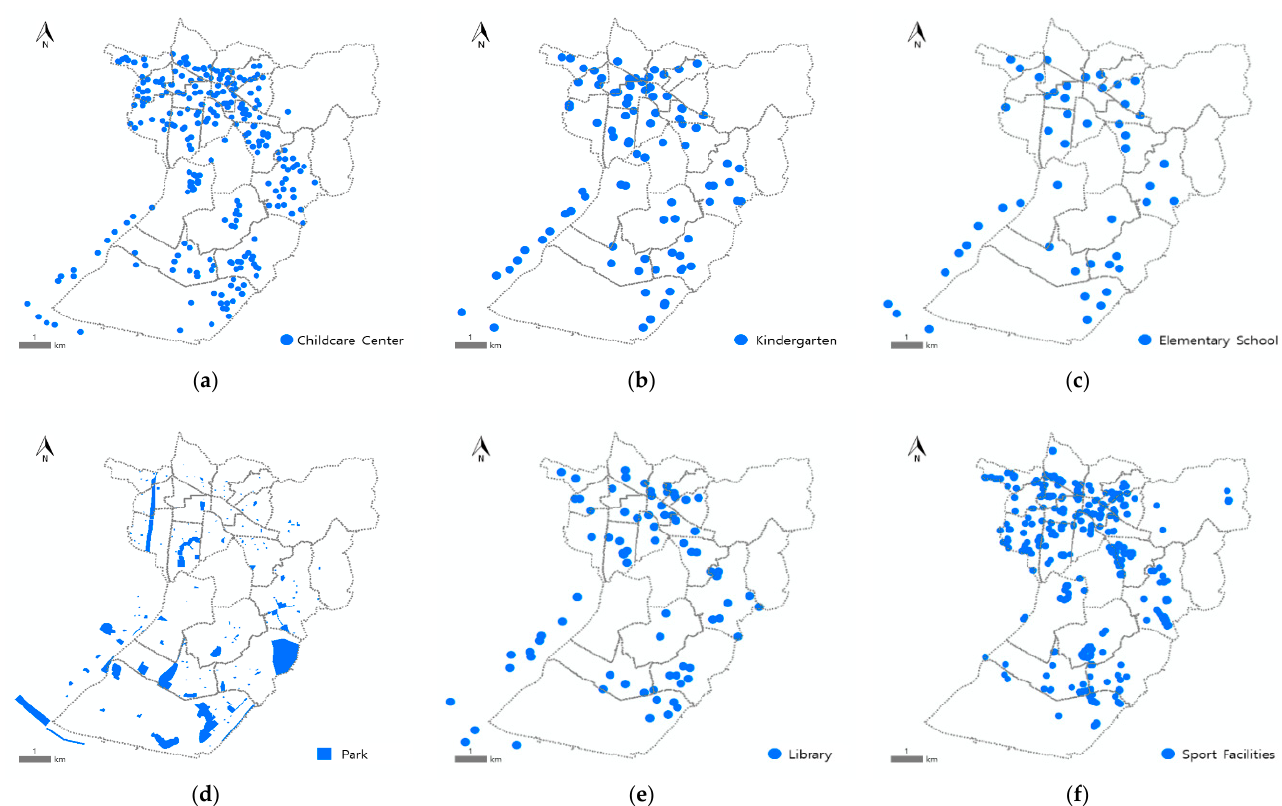
Figure 3. Social infrastructure facility spatial data: ( a ) childcare centers; ( b ) kindergartens; ( c ) elementary schools; ( d ) parks; ( e ) libraries; ( f ) sports facilities.